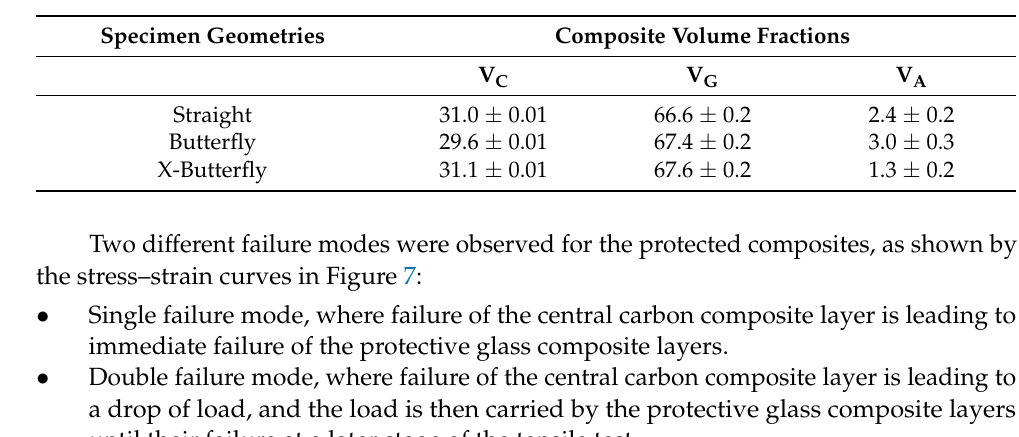
Table 1. Measured composite volume fractions (%) in the three specimen geometries of the protected carbon composites